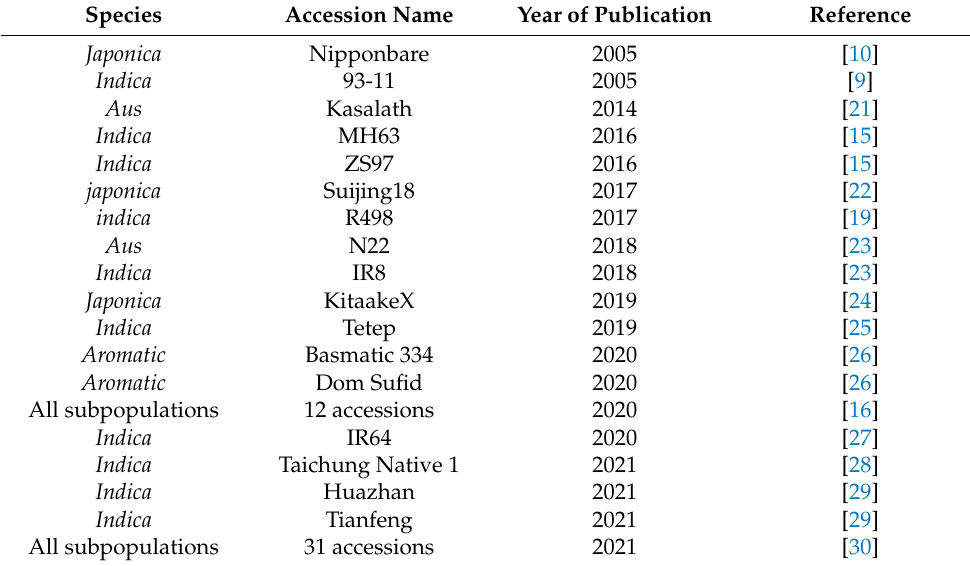
Table 1. High quality reference genomes of Asian